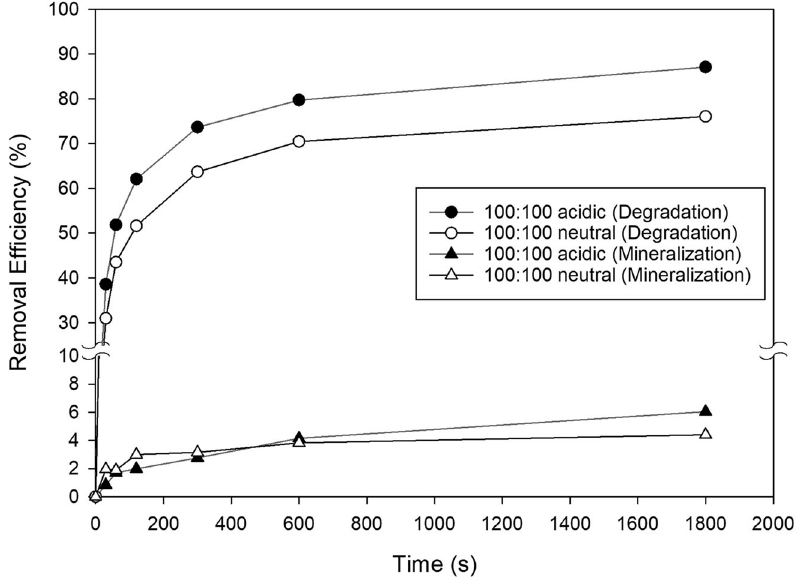
Fig. 3 CBZ removal in different pH environment. The degradation and mineralization ef fi ciencies of CBZ by Fenton process at initial pH 3 and